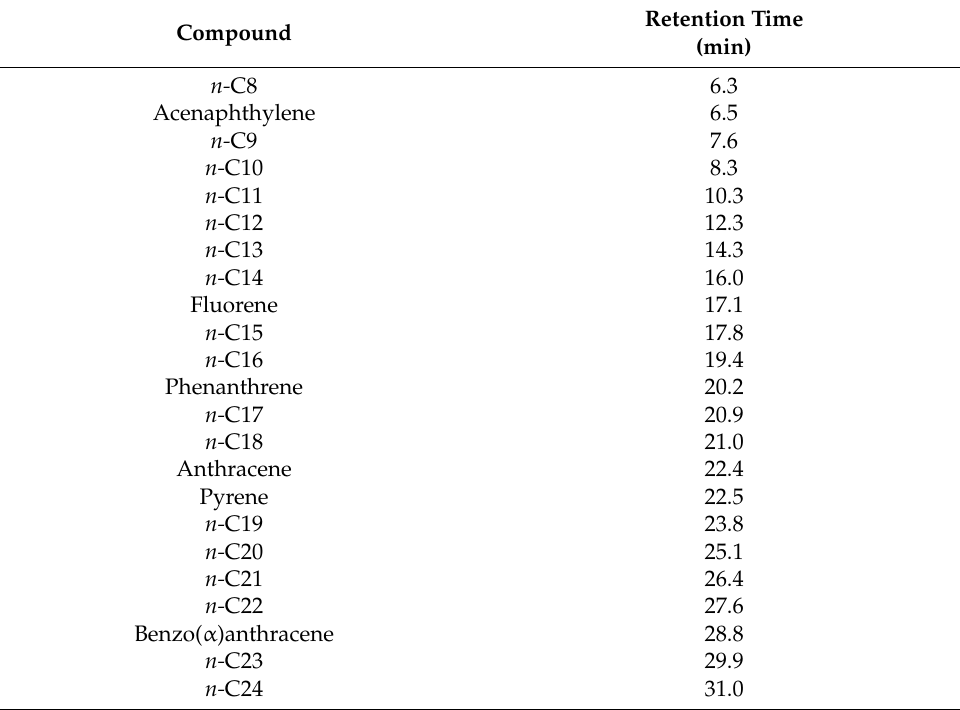
Table 1. Identified hydrocarbons and their retention